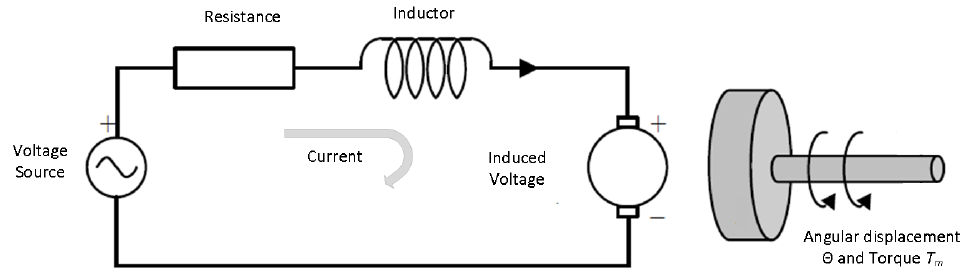
Figure 5. Mathematical Model of BLDC